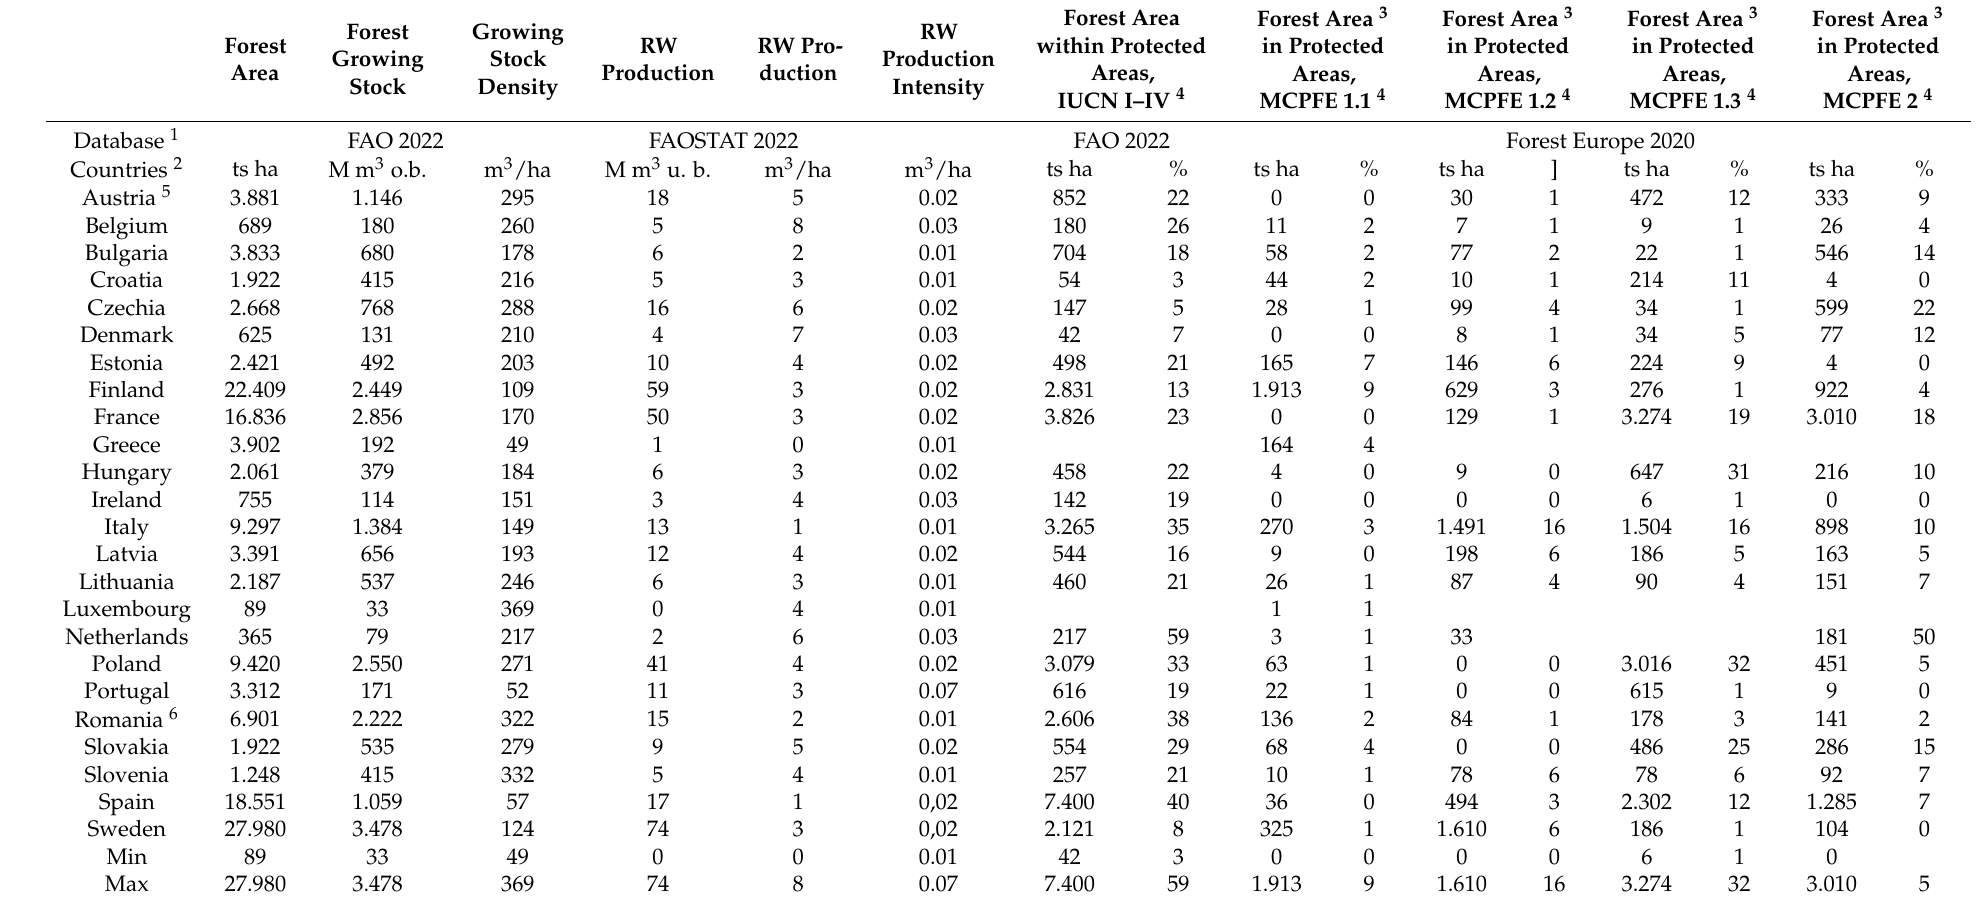
Table A1. Key figures related to forest area, growing stock and roundwood production and forest protection in EU member states. RW is Roundwood, ts ha is thousand hectares, M is million, o.b. and u.b. is over and under bark, respectively (Source: FAO [21], FAOSTAT [17], Forest Europe